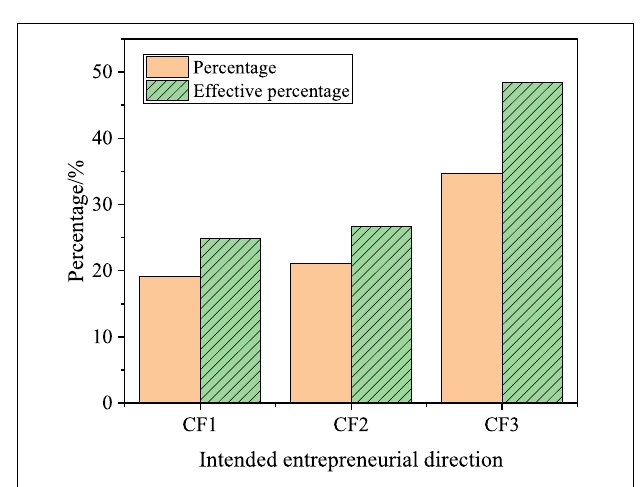
FIGURE 14 | Statistics of college students’ entrepreneurial